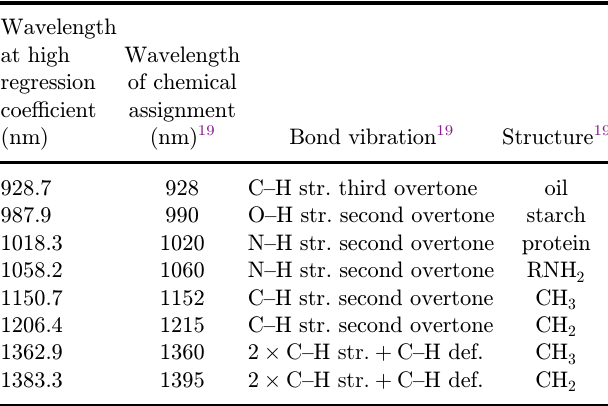
Table 2. Chemical assignments of near-infrared absorption bands associated with high regression